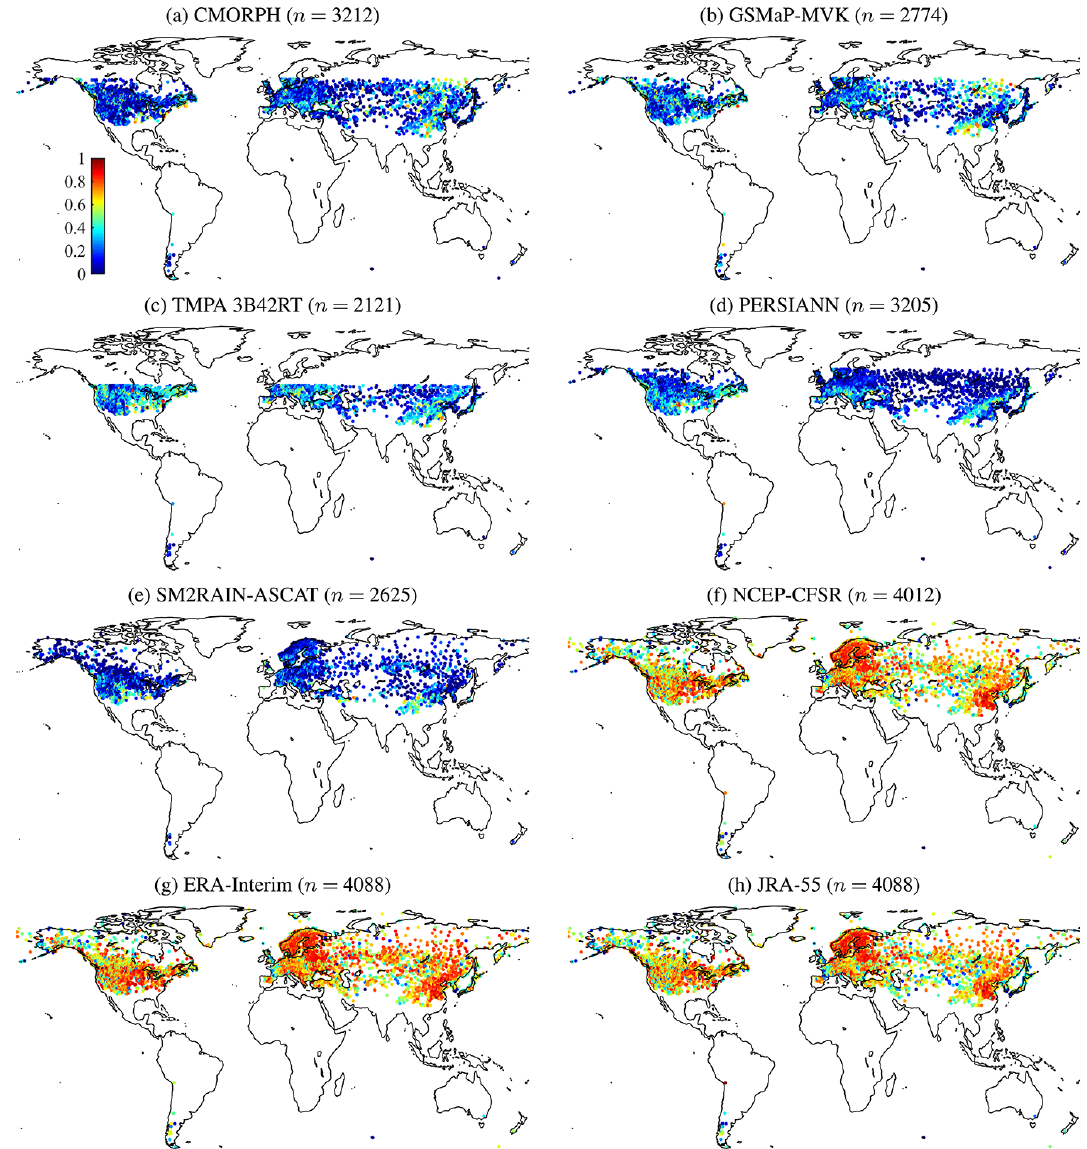
Figure 5. Correlation coefficients calculated between 3-day mean snowfall derived from the datasets and the gauges. Each data point repre- sents a 0.5 ◦ grid cell containing at least one